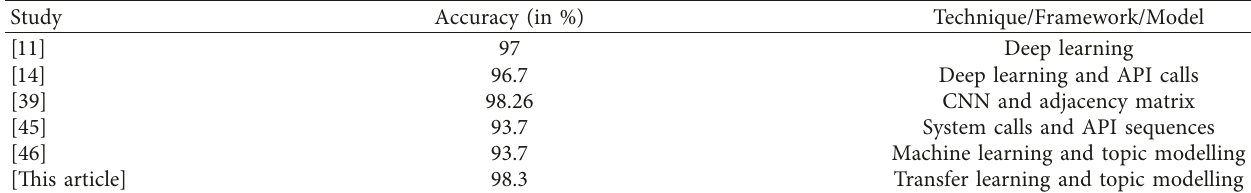
Table 6: Comparative analysis of experimental outcomes of different techniques.